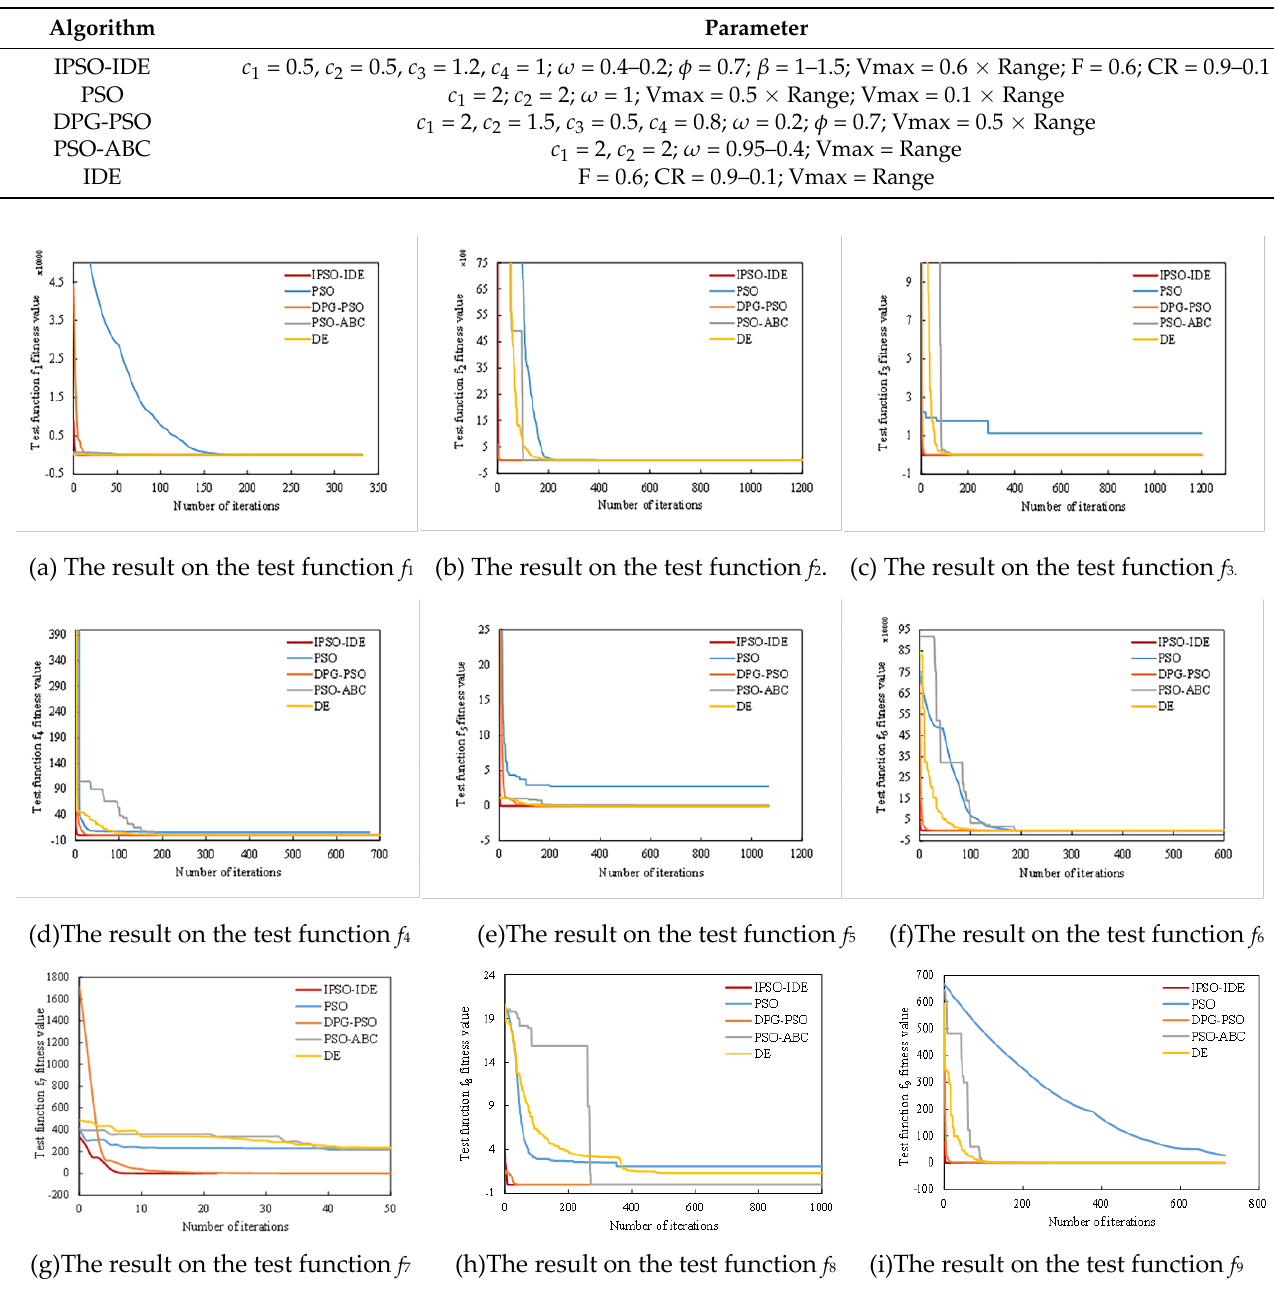
Figure 2. The optimal fitness curves obtained based on test functions f1 − f9 by fi ve algorithms .